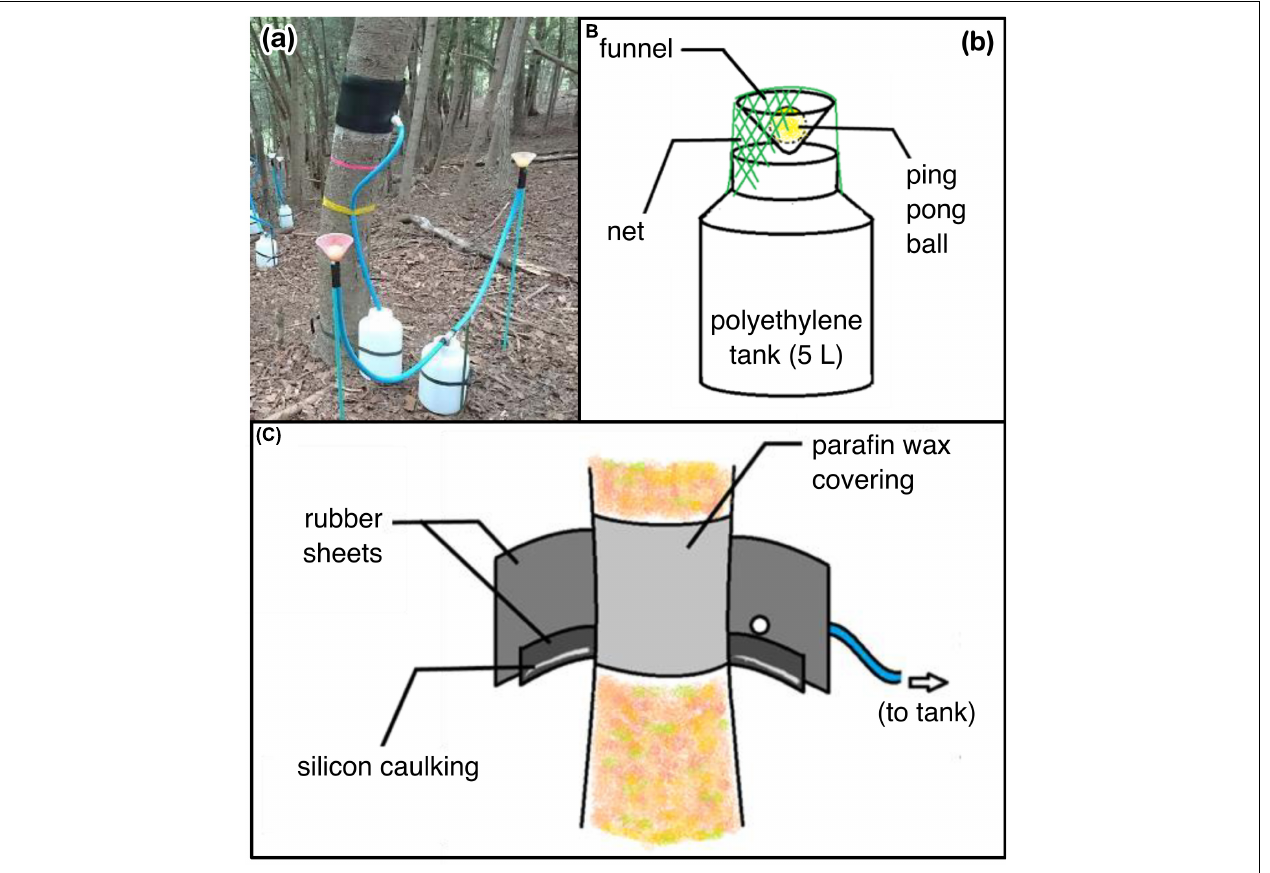
FIGURE 3 | Photograph and diagrams of the water sampling system. (a) Photograph of the implementation on Abies firma at the Shizuoka site, (b) diagram of water collector for direct rainfall, (c) water collection system for